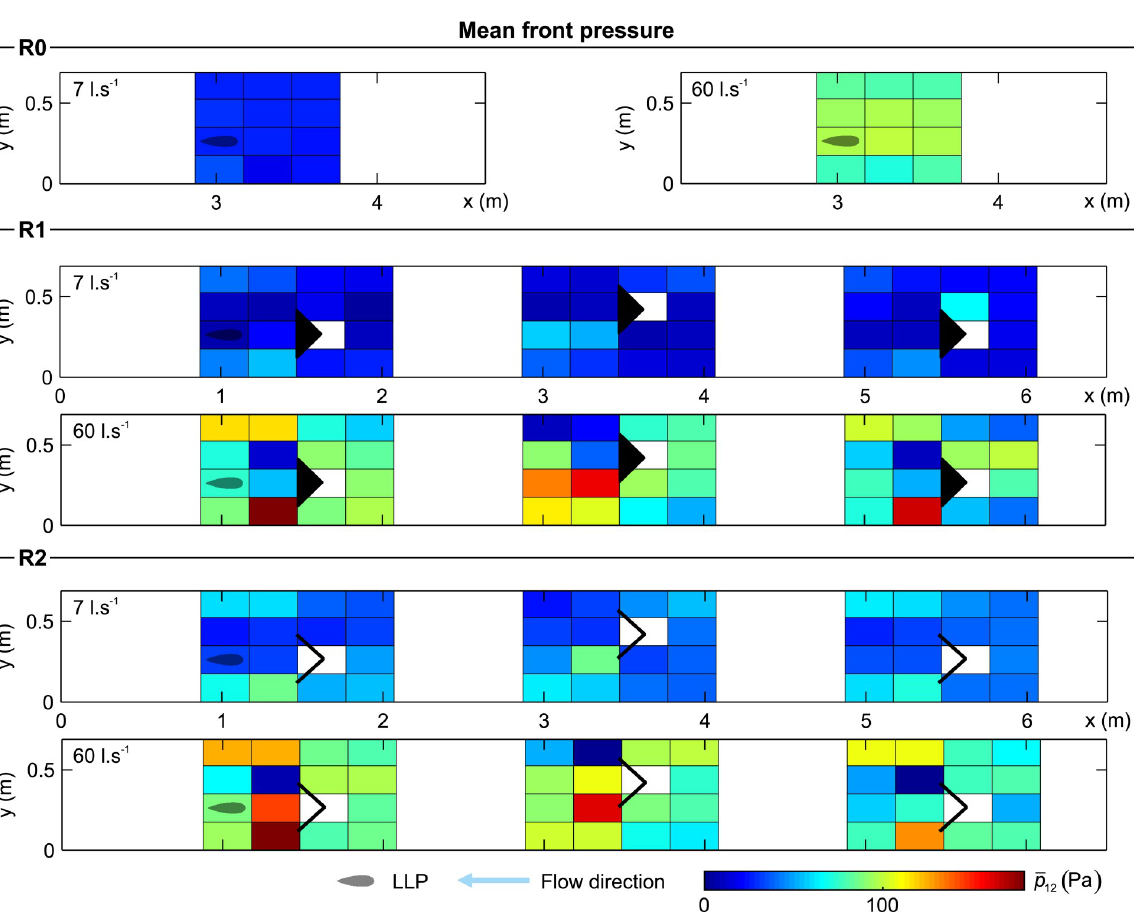
Fig 7. Distribution of mean front pressure ( � p ) for all configurations and both discharge scenarios considered (7 and 60 l.s -1 ). The reader 12 is referred to supporting information (S1 Fig) to look at the contour representation of this figure.